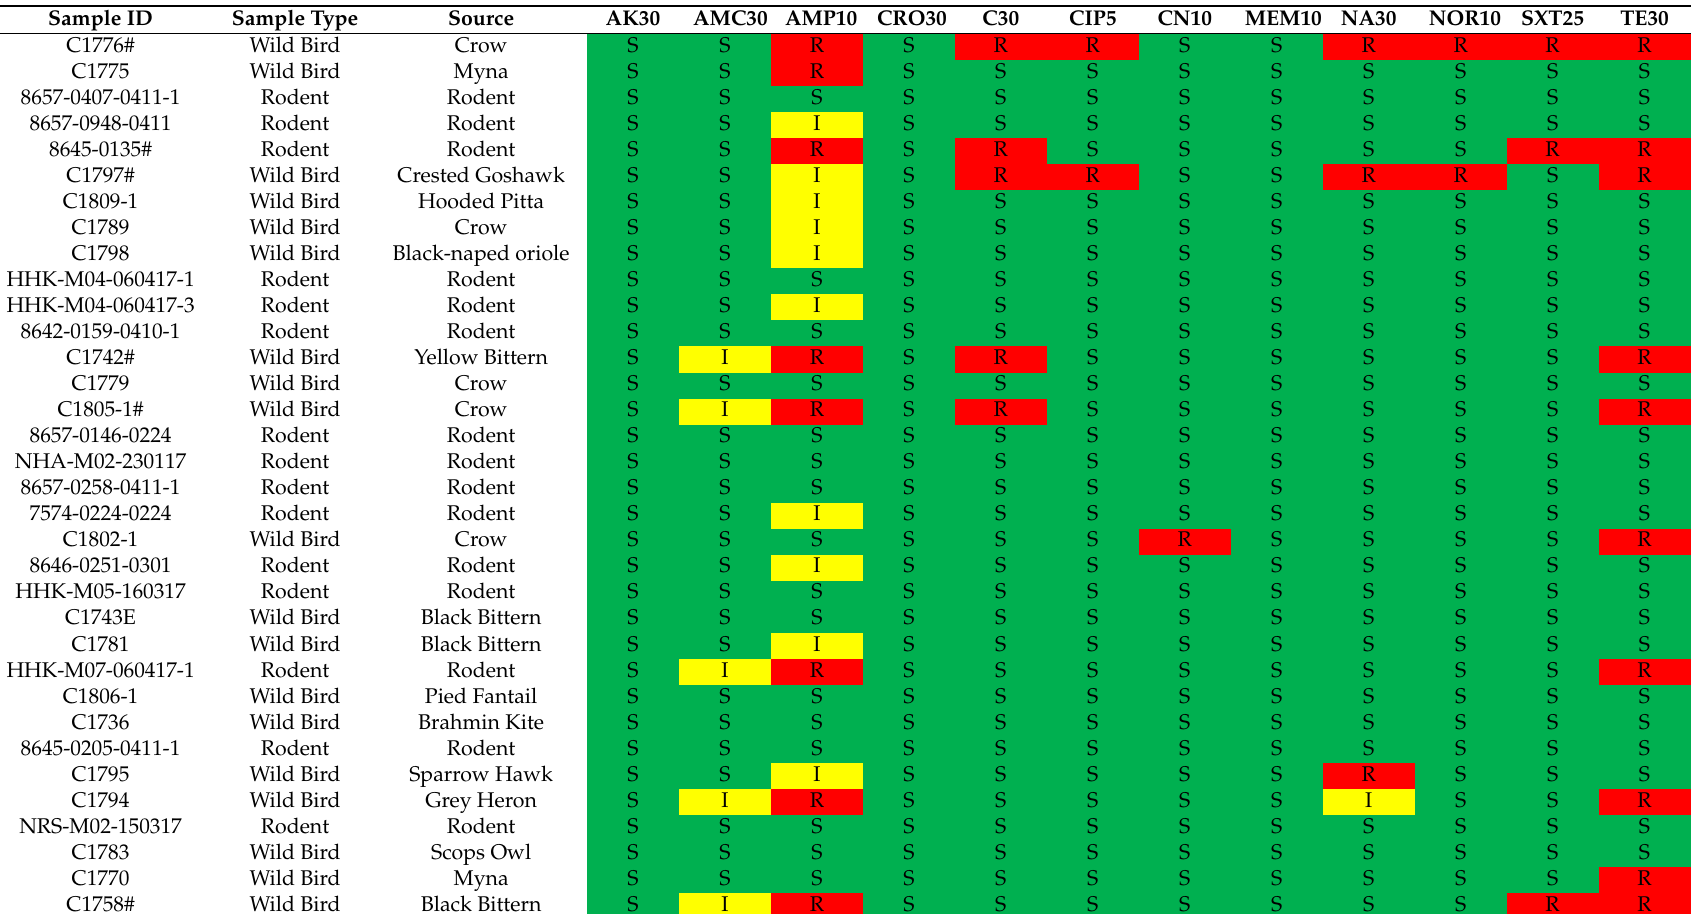
Table 1. Antimicrobial susceptibility profiles of E. coli isolates from wild birds and rodents (#: Multi-drug resistant strain; S: Susceptible; I: Intermediate; R: Resistant. Antimicrobial agents used for testing were AK: Amikacin; AMC: Amoxicillin / Clavulanic acid; AMP: Ampicillin; C: Chloramphenicol; CIP: Ciprofloxacin; CN: Gentamicin; CRO: Ceftriaxone; MEM: Meropenem; NA: Nalidixic acid; NOR: Norfloxacin; SXT: Sulphamethoxazole / Trimethoprim; TE: